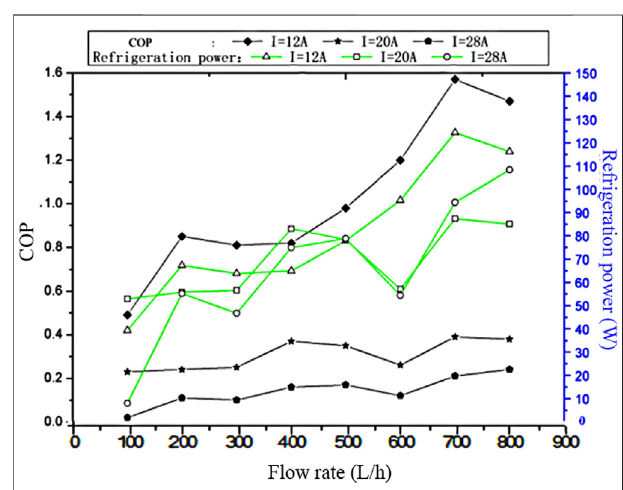
FIGURE 9 | Refrigeration power and COP under different working